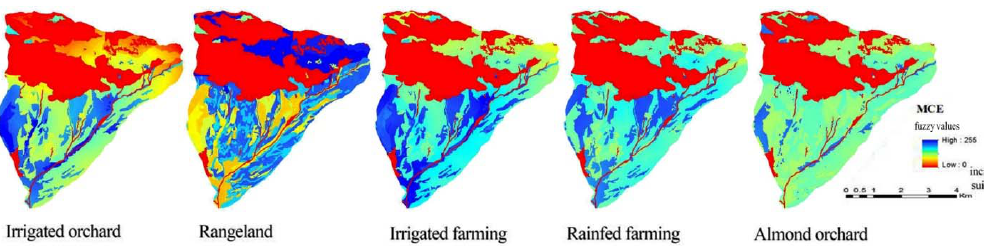
Fig. 4: Suitability maps for different land uses produced by WLC